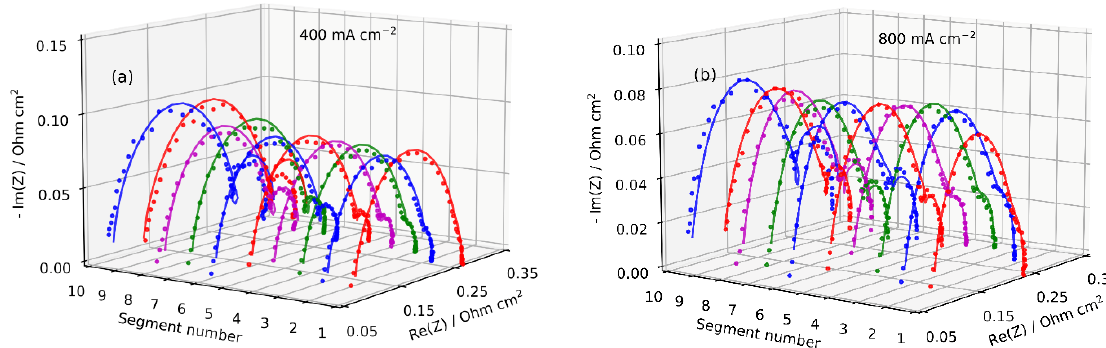
Figure 5. Experimental (points) and fitted model (lines) local Nyquist spectra from the individual segments at 400 ( a ) and 800 mA cm − 2 ( b ). Air inlet is at segment 1, outlet is at segment 10.